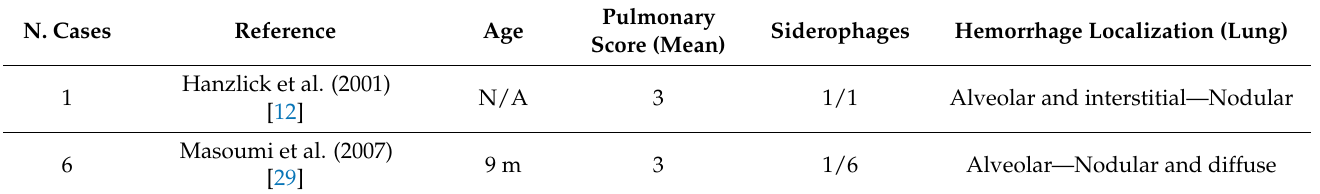
Table 3. Summary findings of the postmortem evaluation of AIPHI cases reported in the